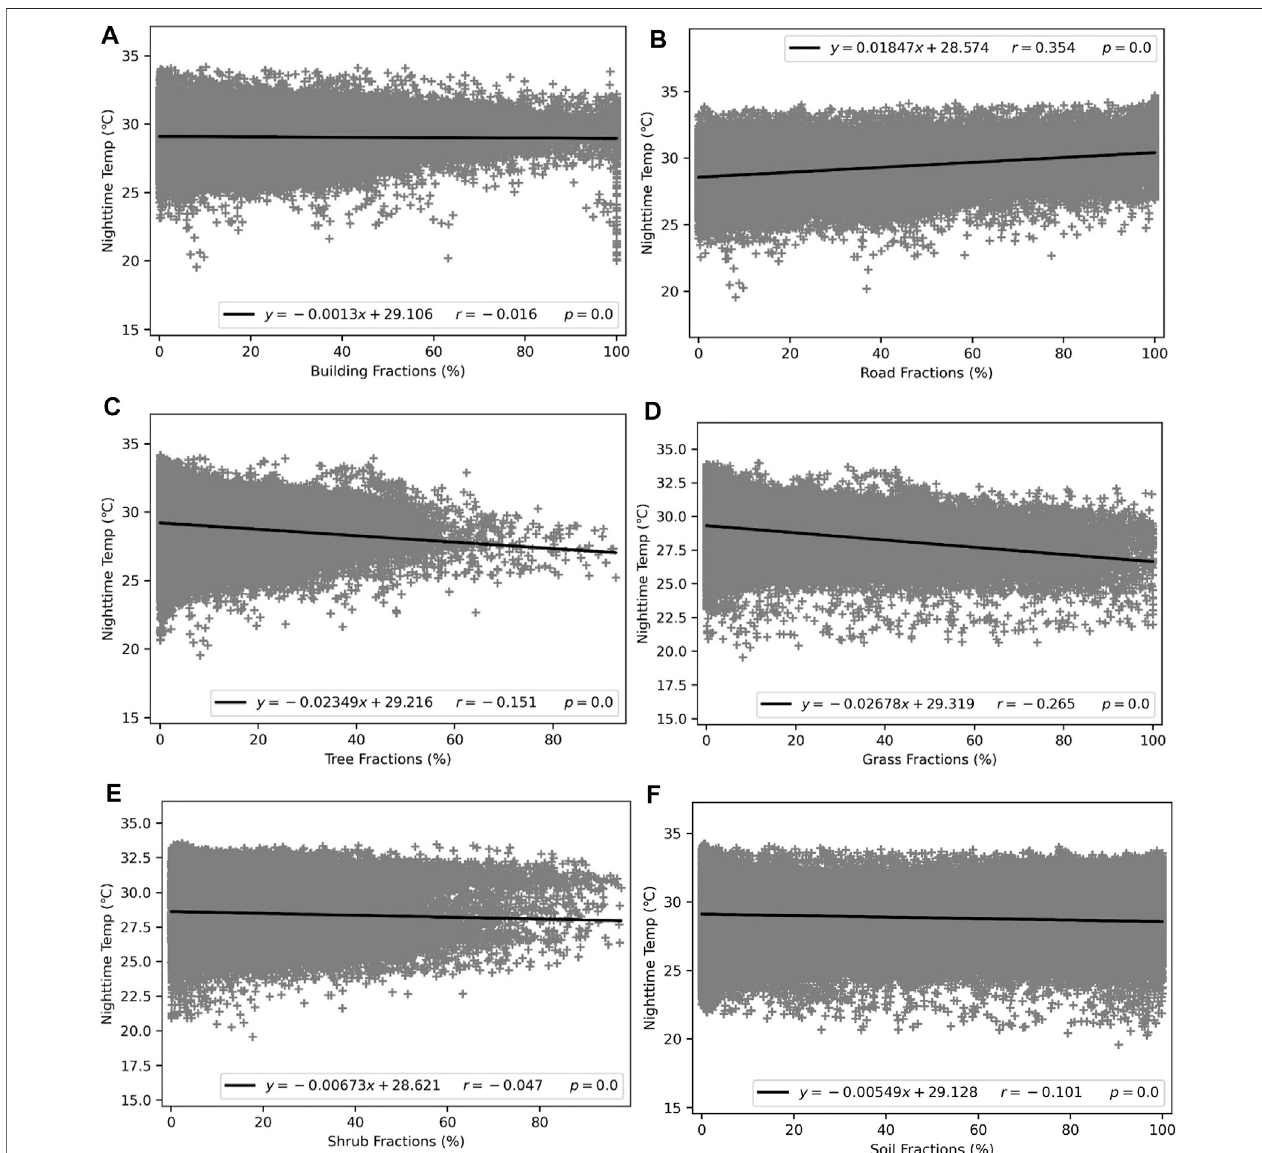
FIGURE5| RelationshipbetweensummernighttimeLSTandselectedLULCfractionsinPhoenixincluding (A) building, (B) road, (C) tree, (D) grass, (E) shrub,and (F) soils, determined by linear regression.